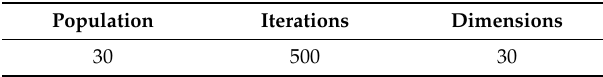
Table 6. Parameters used in the experiments.